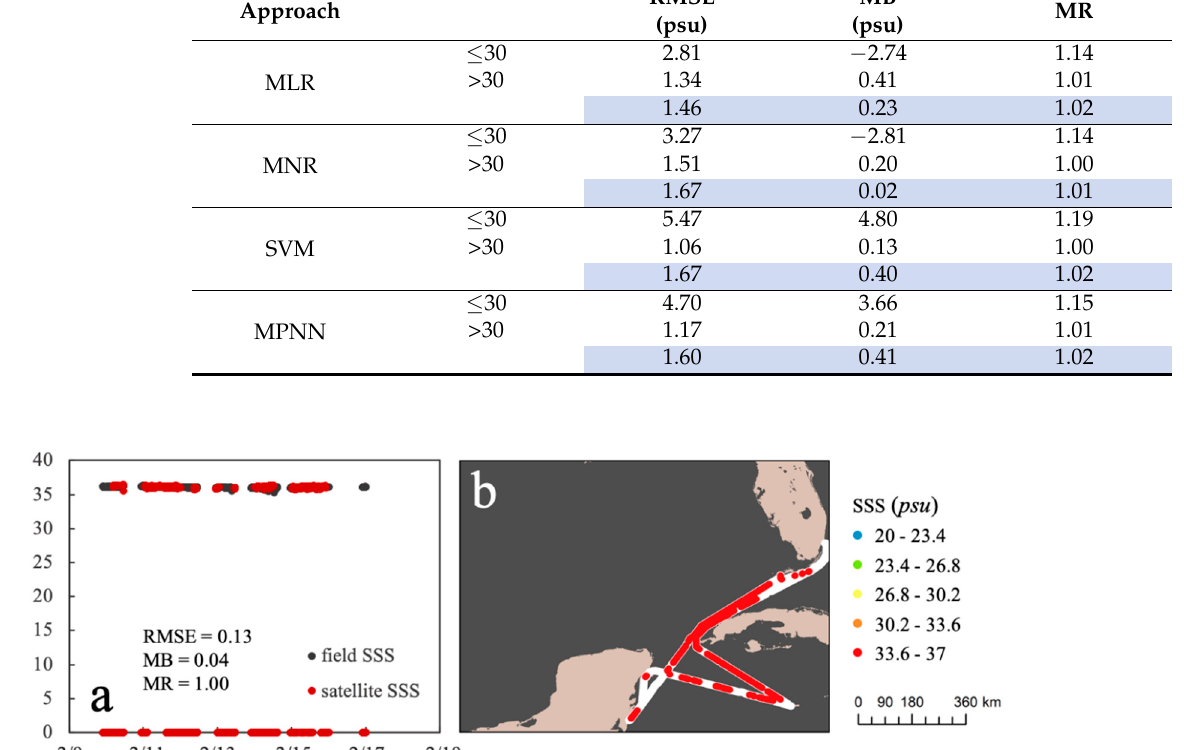
Table 7. Model comparison in independent validation of cruise GU1609Leg1-3 Fall Pelagic Trawl/Acoustic Survey, the overall result of each cruise was listed with blue background. Approach